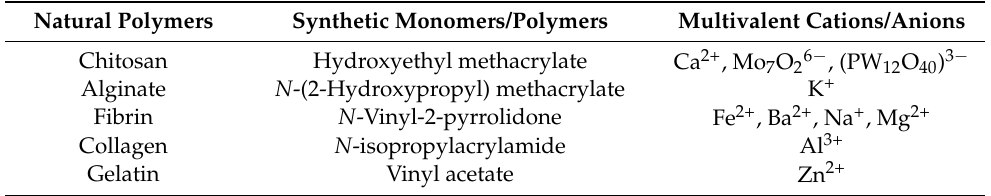
Table 1. Polymers and polyelectrolytes used in ionotropic gelation. Adapted from [160] under open access CC-BY